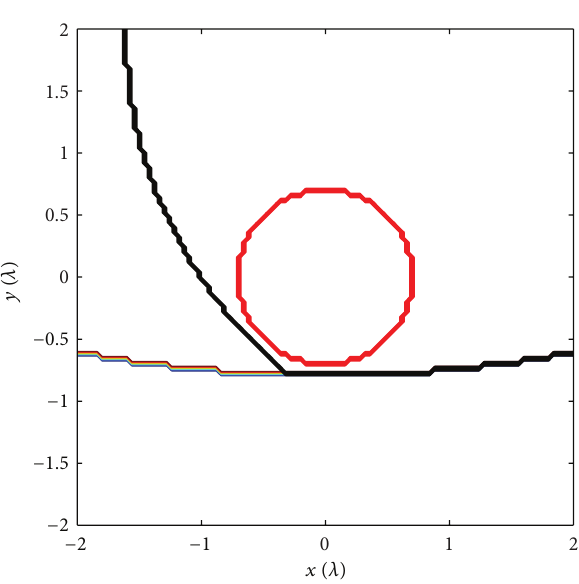
Figure 11: Improved boundary of the minimum source region corresponding to two test origins: (𝑥 = 2, 𝑦 = 2) and (𝑥 = 0, 𝑦 = 10)